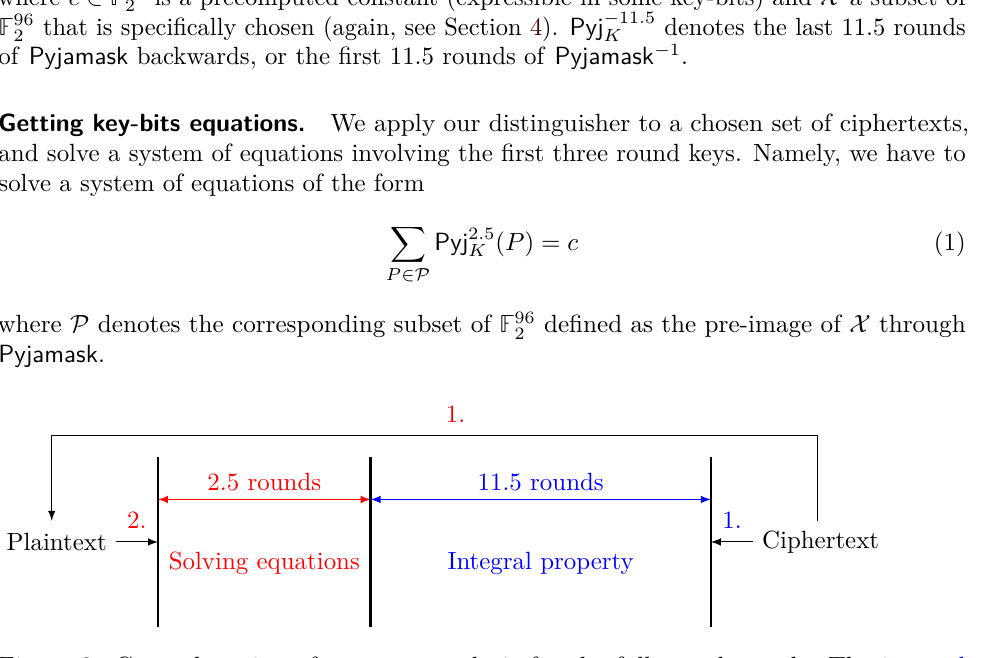
Figure 3: General setting of our cryptanalysis for the full-round attack. The integral property and the solving of